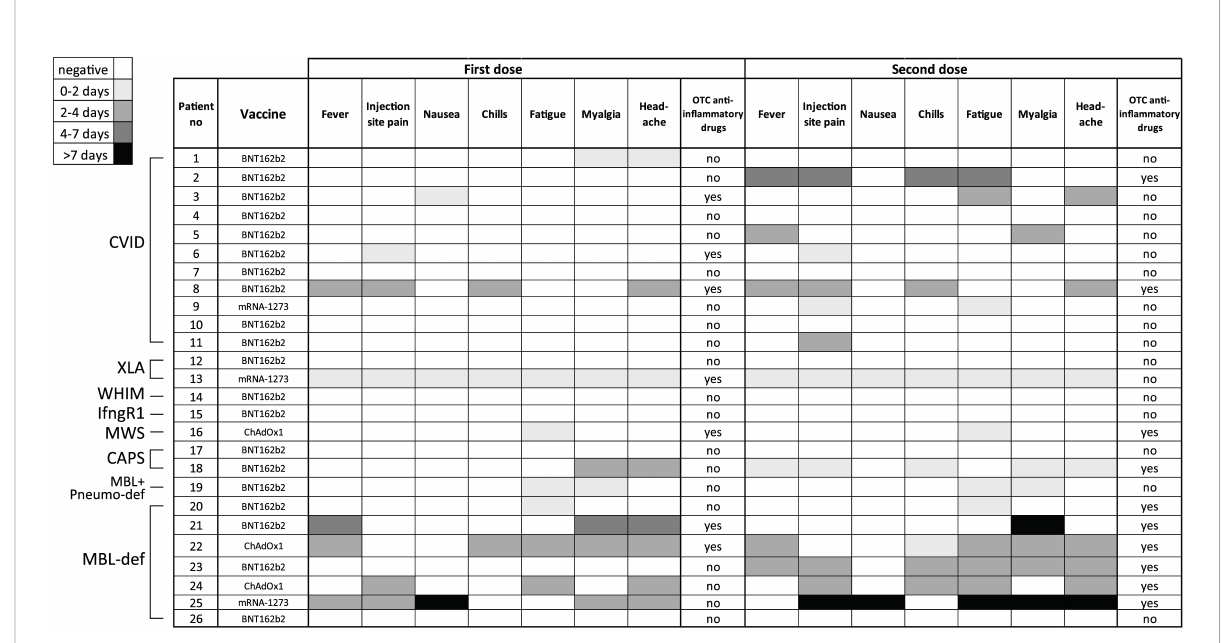
FIGURE 4 Summary of the duration of the reactogenicity and use of over-the-counter anti-in fl ammatory drugs in individual patients vaccinated with the indicated vaccines. Duration of the symptoms were structured and gray-scale coded into four